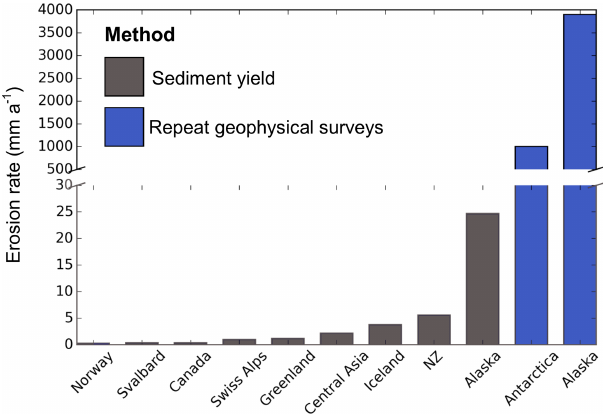
Figure 6. Mean erosion rates from previously published literature in a range of locations. Data taken from Hallet et al. (1996, and references therein), Koppes and Hallet (2006), Motyka et al. (2006), Cowton et al. (2012) and Smith et al. (2007,